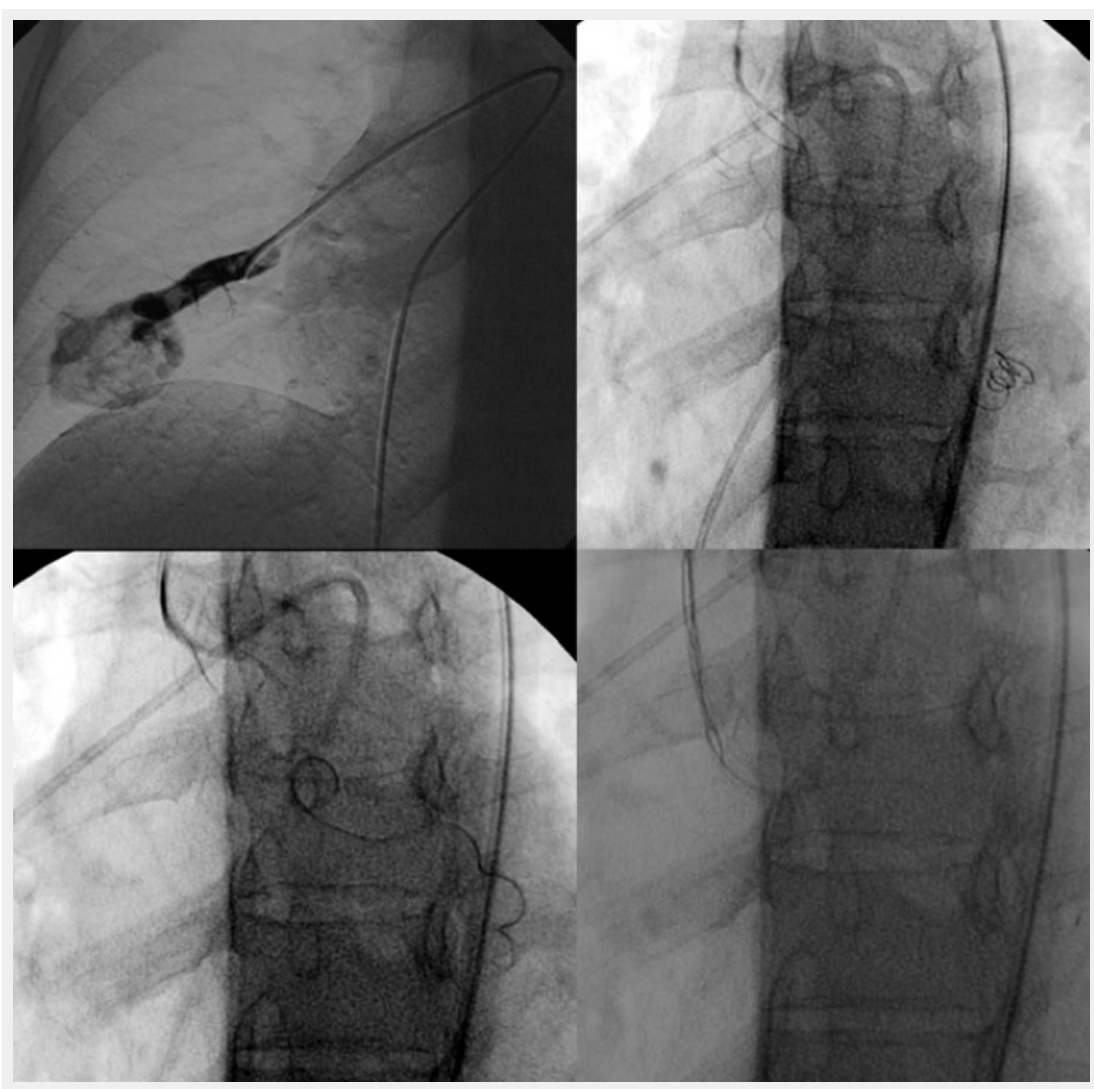
Figure 4 Embolisation attempt of a large pulmonary arteriovenous malformation (PAVM) with a feeding artery of 12 mm diameter with a 10/5 mm 10.035 Tornado ® coil. Owing to the size of the AVM, distal translocation of the coil in the left ventricle occurred. A snare-assisted removal was then performed before a second and successful attempt at occluding this